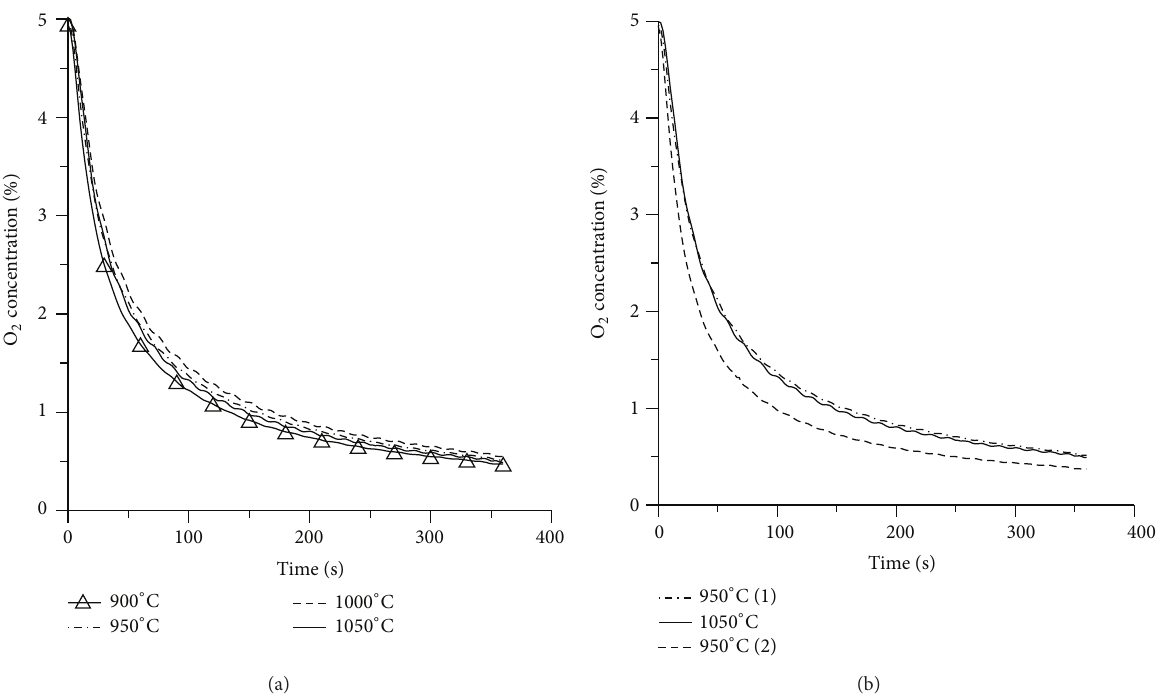
Figure 11: The O 2 concentration profile of inert cycles for the 5.6% MgO 1300 oxygen carrier; (a) oxygen concentration versus time as a function of temperature and (b) the comparison of oxygen profiles at 950 ∘ C before and after 1050 ∘ C cycles. Data obtained from the second conducted cycle is presented.